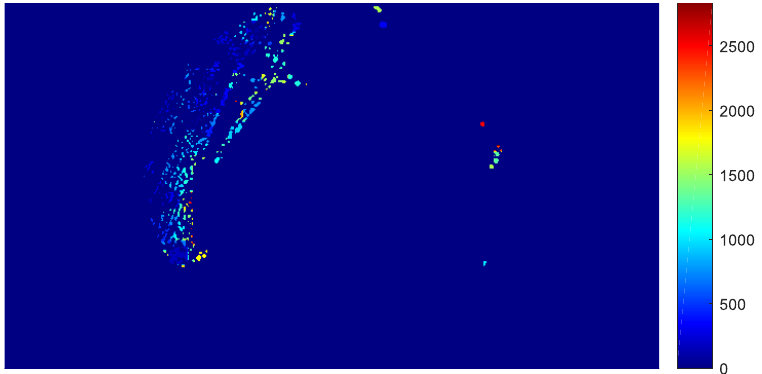
Figure 12. Parametric image of the time of first microbial appearance t s